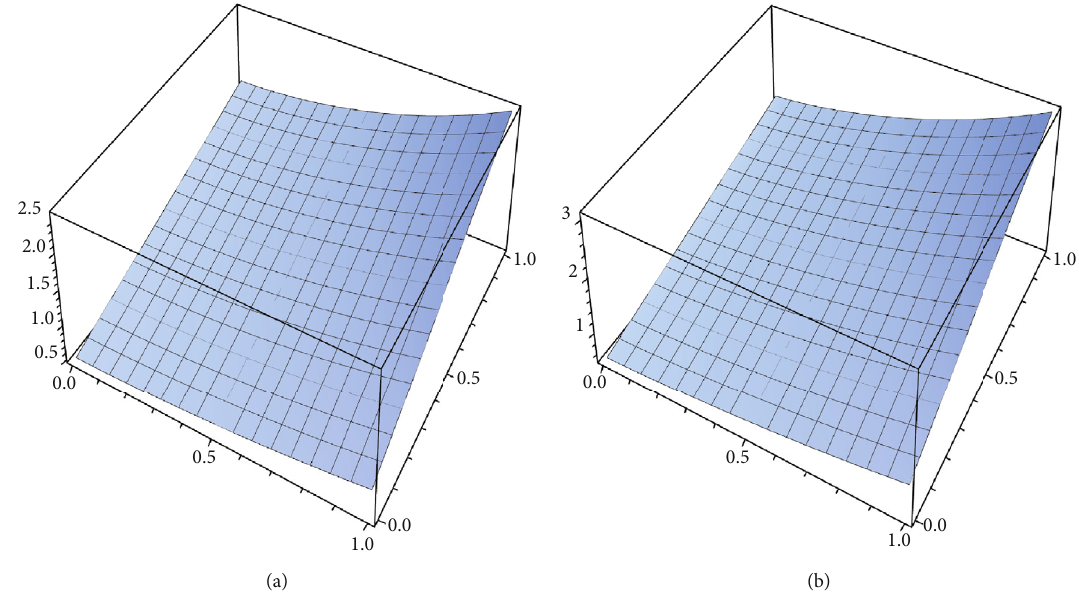
Figure 1: The FRDTM solutions u ð x , y , z Þ : (a) nonfractional exact α = 2 and (b) nonfractional tenth-order approximate α = 2